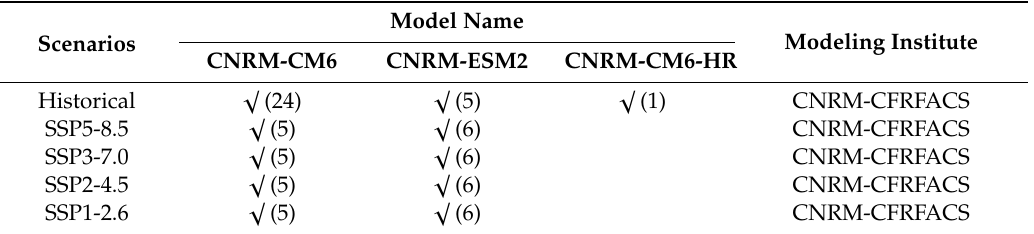
Table 1. Global climate models’ (GCMs’) historical and future scenarios used in the study along with their number of ensemble members and modeling institute [70].